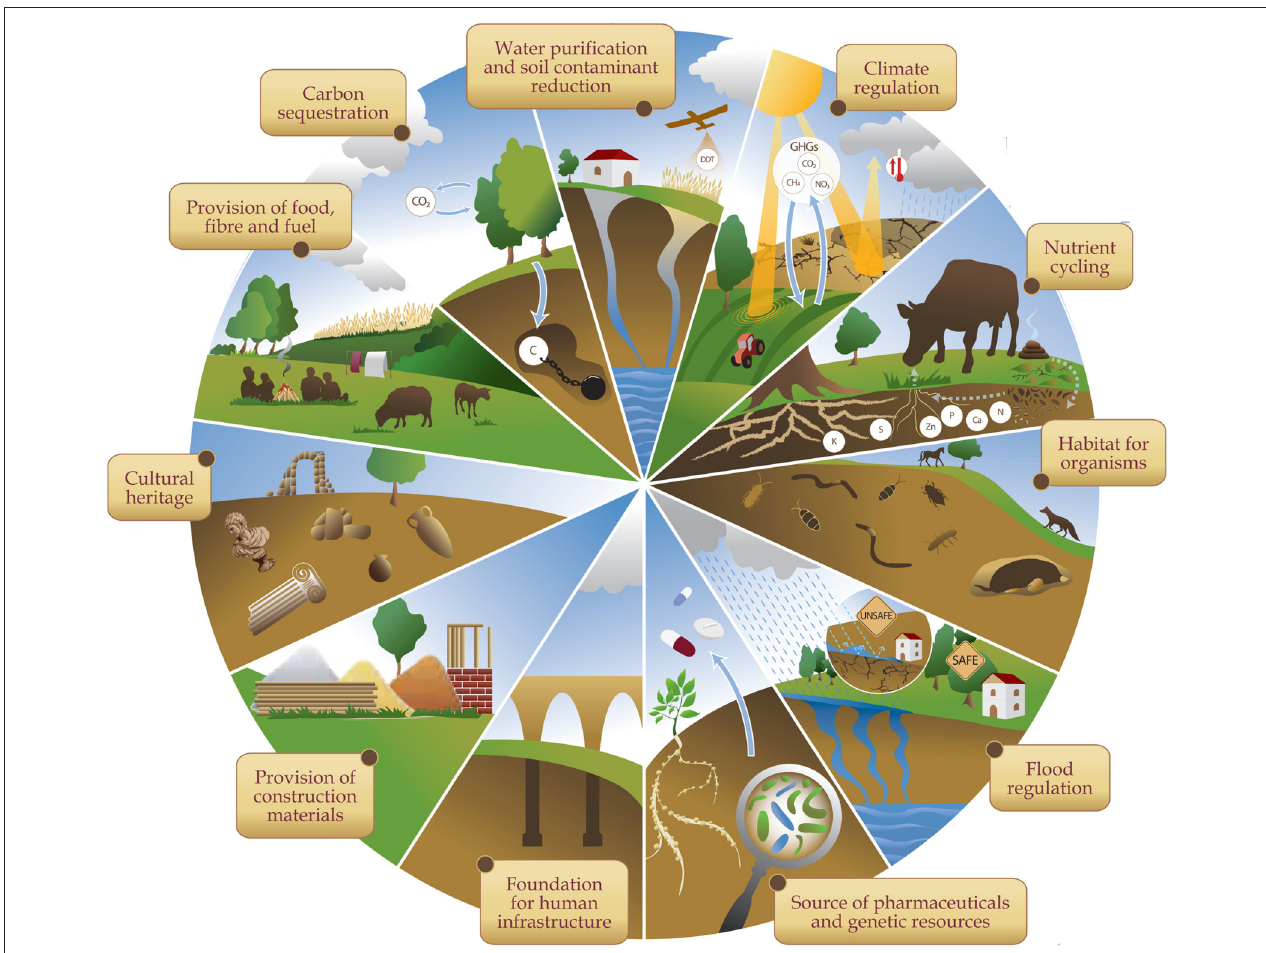
FIGURE 2 | Schematic diagram of soil functions. This diagram is part of an “infographics” on soil functions put together by the FAO, with the subtitle “Soils deliver ecosystem services that enable life on earth” (Adapted from http://www.fao.org/resources/infographics/infographics-details/en/c/284478/).